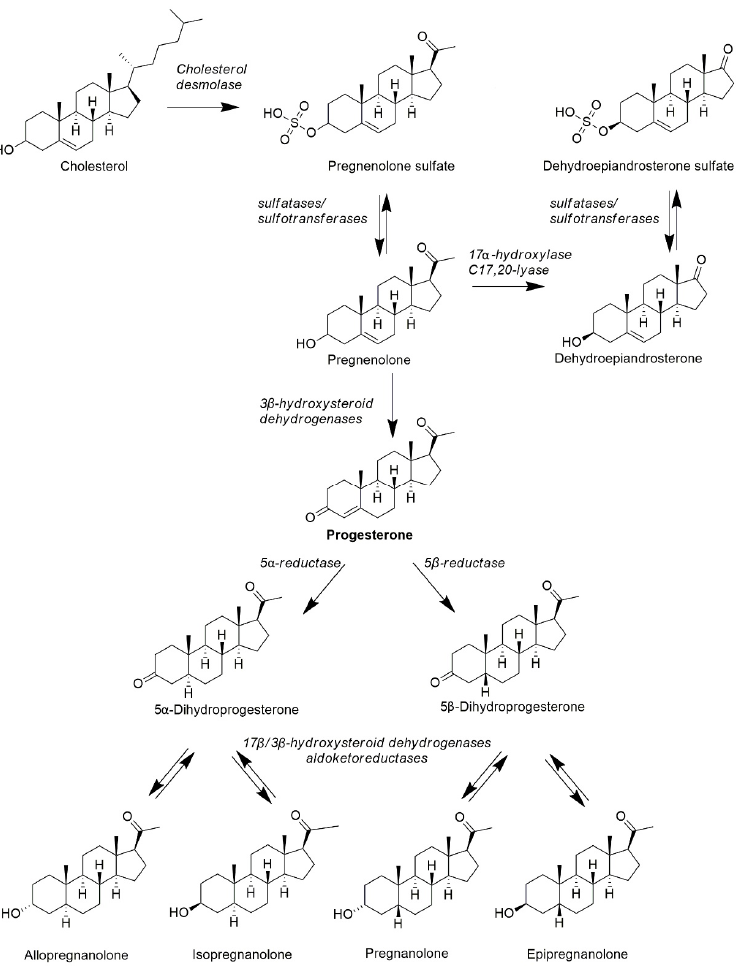
Figure 2. The steroidogenic pathway leading to progesterone and its neuroactive metabolites (preg- nane steroids).